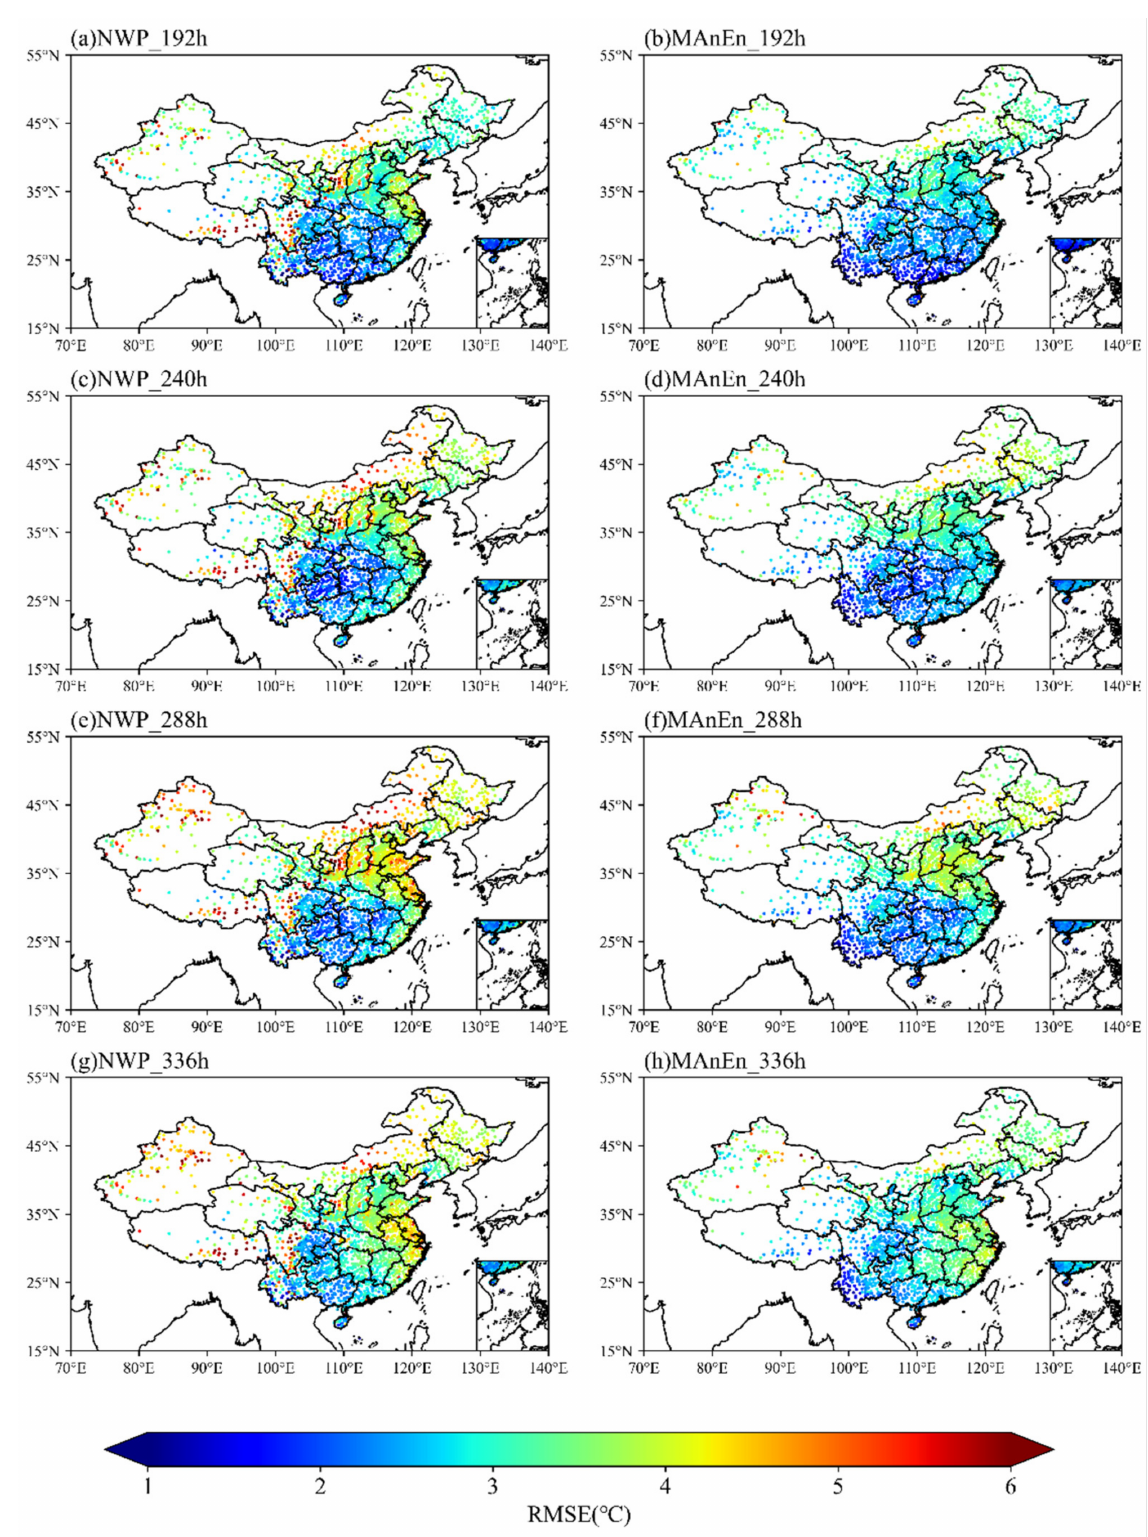
Figure 6. RMSE distribution of model forecasts and analog ensemble averaging forecasts for 2405 stations. (( a , c , e , g ) are model forecasts; ( b , d , f , h ) are analog ensemble averaging